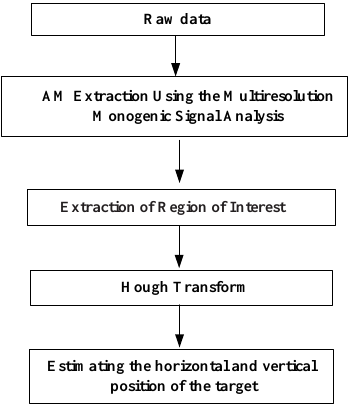
Figure 2. The flowchart of the proposed strategy.